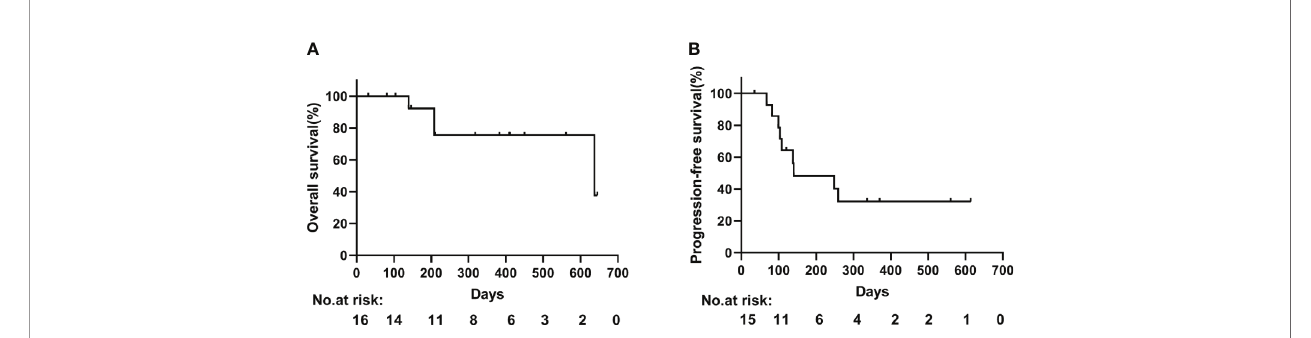
FIGURE 1 | Kaplan-Meier curves of (A) overall and (B) progression-free survival.